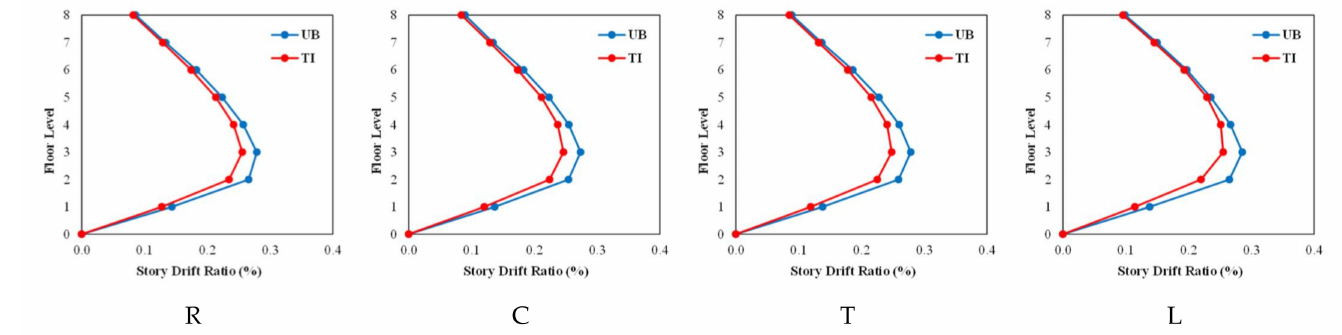
Figure 13. Story drift ratio for R, C, T, and L models.